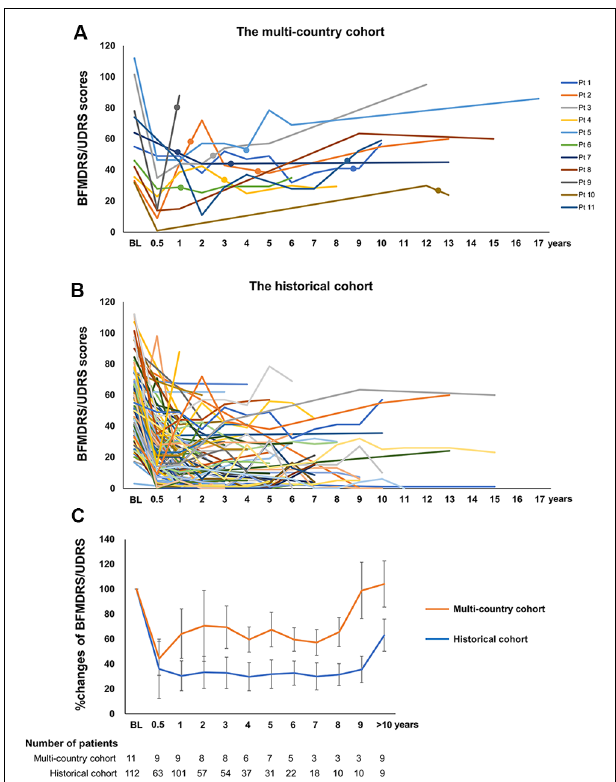
FIGURE 1 | (A) Individual changes of the Burke-Fahn-Marsden Dystonia Rating Scale motor (BFMDRS-M) or Unified Dystonia Rating Scale (UDRS) in the multi-country cohort. (B) The closed circles on each line indicate additional GPi or subthalamic nucleus (STN) implantations. Individual changes of the BFMDRS-M or UDRS in the historical cohort. (C) Comparison of percent improvement of the BFMDRS-M/UDRS in the multi-country cohort and the historical cohort. Orange and blue line graphs represent mean scores for the multi-country cohort and the historical cohort, respectively. Whiskers represent standard errors. BFMDRS-M, Burke-Fahn-Marsden Dystonia Rating Scale motor score; UDRS, Unified Dystonia Rating